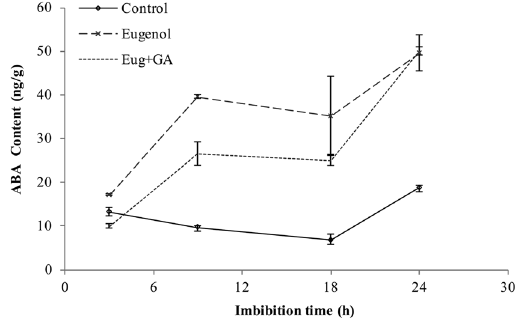
Figure 5. Changes of ABA contents in the presence of eugenol and eugenol + GA 3 combined treatments during seed germination of Qian You 1. Control: seeds soaked in water; Eugenol: seeds soaked in 2.0 g · L − 1 of eugenol; Eug + GA: seeds soaked in 2.0 g · L − 1 eugenol + 50 mg · L − 1 of GA 3 mixed solution. The data were the means of three replications, and the standard deviation was indicated by